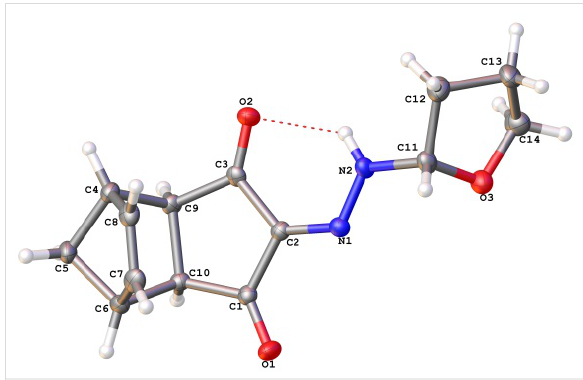
Figure 2: Molecular structure of hydrazone 2b as determined by X-ray analysis data (Olex2 plot with 50% probability level of ellipsoids).